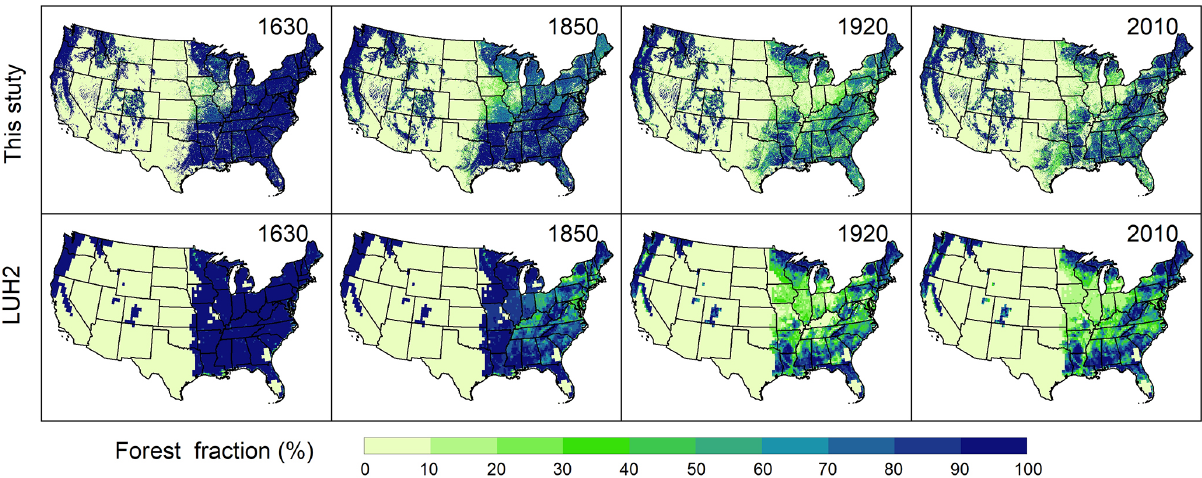
Figure 18. Comparison of forest distribution between this study (upper row) and Land Use Harmonization (LUH2) (lower row) for the conterminous United States.